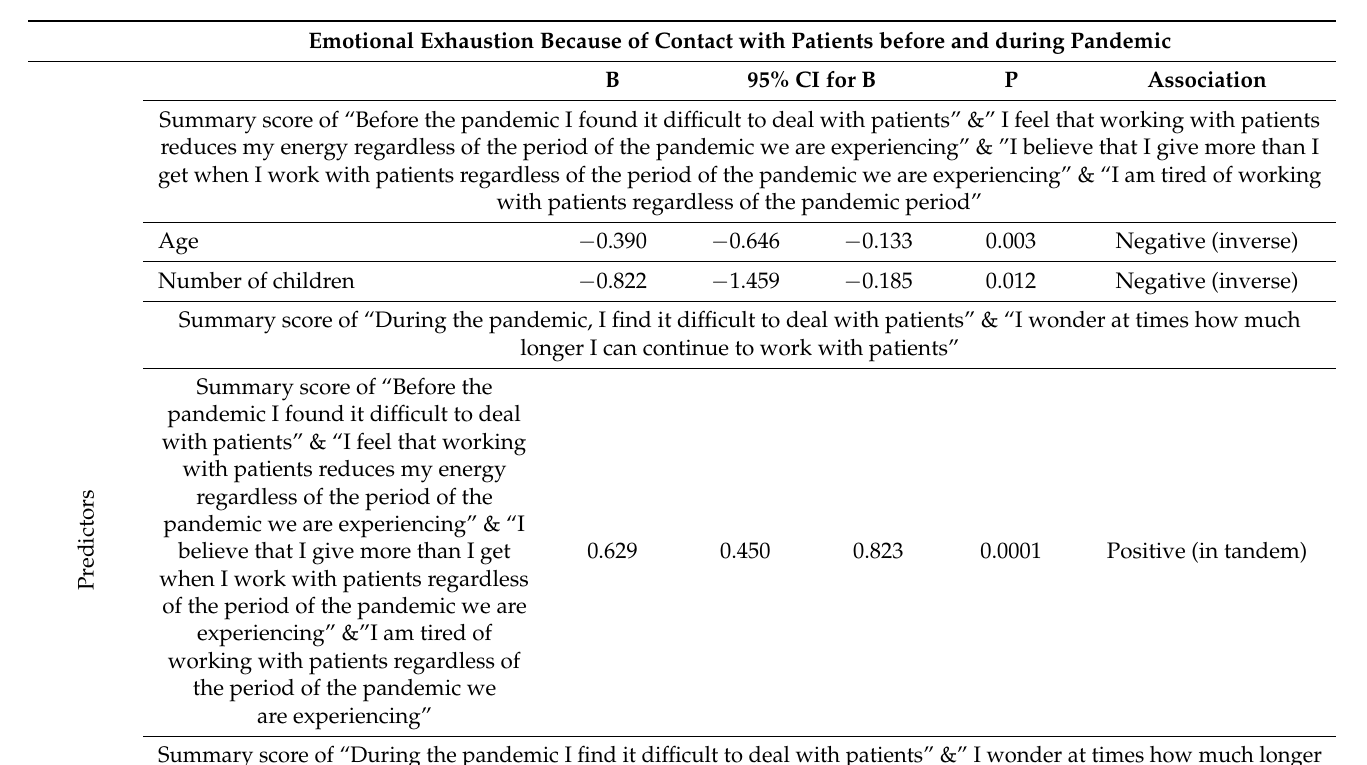
Table 3. Results on emotional exhaustion because of contact with patients (multiple linear regression